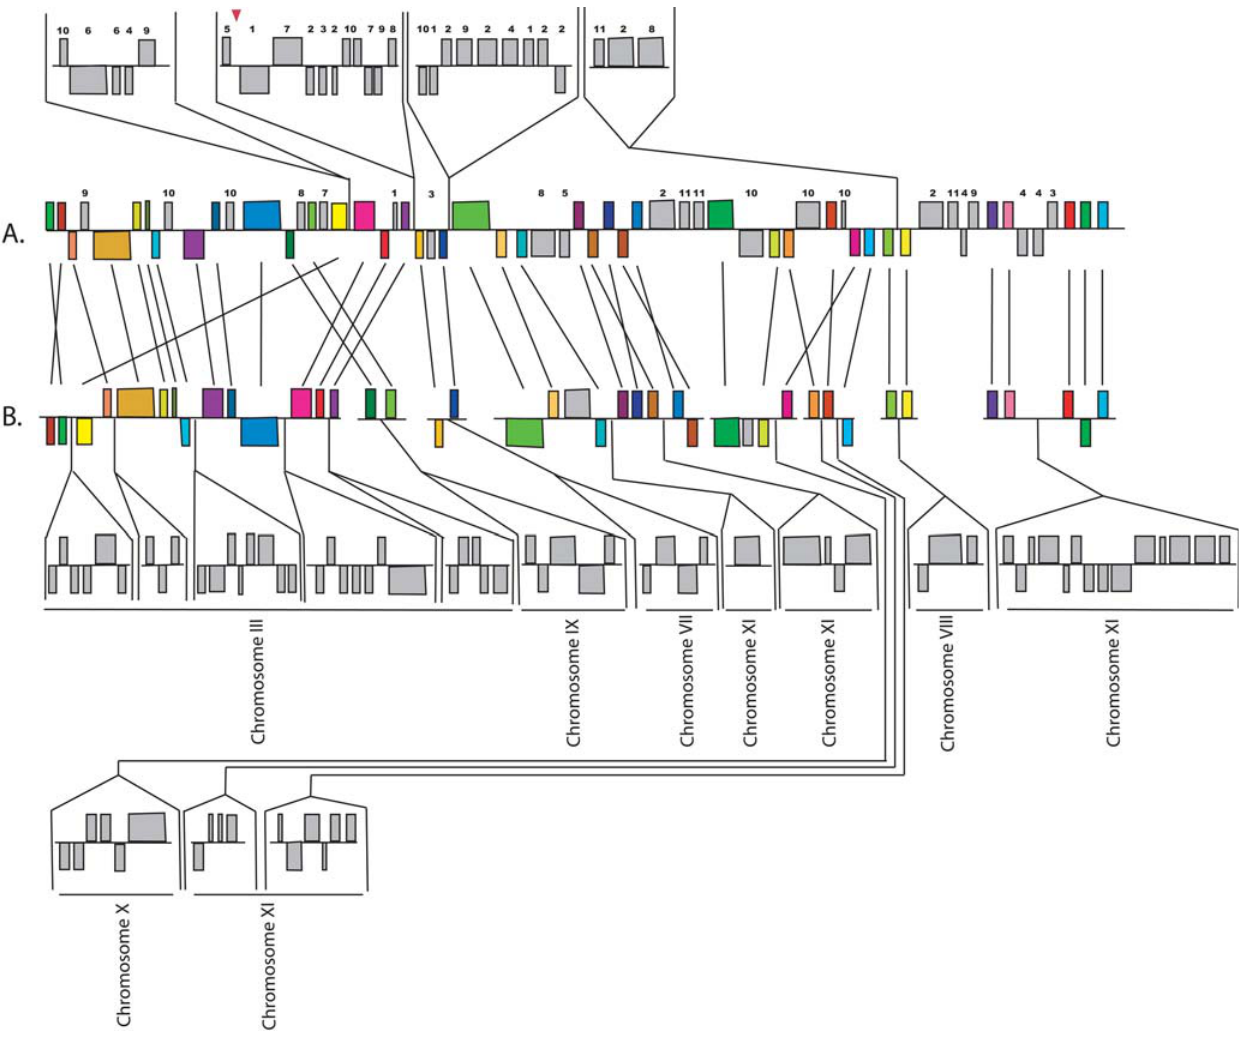
Figure 2. Analysis of contigs included in the scaffold SC_2384 and gene order comparisons between the E.bieneusi(A) and E.cuniculi(B) orthologues. Coloured boxes represent orthologues in the same context in both genomes, and the chromosome on which each E. cuniculi segment is located is indicated by Roman numerals. Grey boxes represent genes that are not identifiably orthologous or are not conserved in context. Regions of both genomes transposed above or below the aligned regions represent blocks of genes in different contexts. The chromosomal location of the E. cuniculi orthologue of such genes from E. bieneusi is indicated by Arabic numerals above the boxes. The chromosomal location of syntenic ORFs in the genome of E. cuniculi is shown in the lower part of the figure and annotated with Roman numbers. Straight lines join the homologous ORFs. Red triangles represent boundaries between the contigs used to generate the scaffolds presented in these figures.